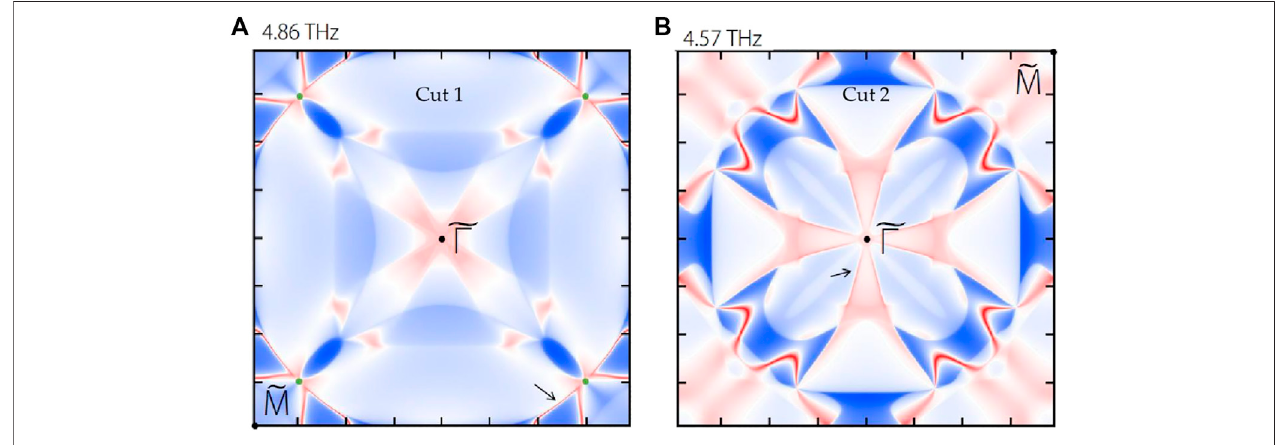
FIGURE 6 | Calculated iso-frequency surface contours at (A) 4.86 THz and (B) 4.57